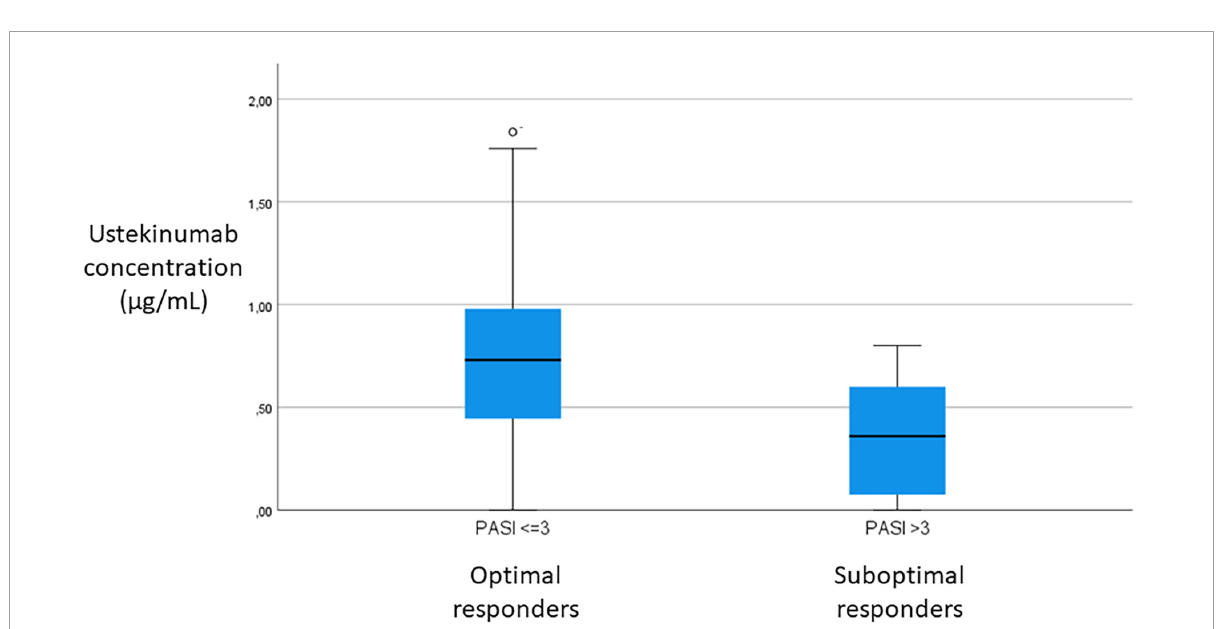
FIGURE1 Comparison of ustekinumab concentration between optimal (PASI ≤ 3) and suboptimal (PASI > 3)